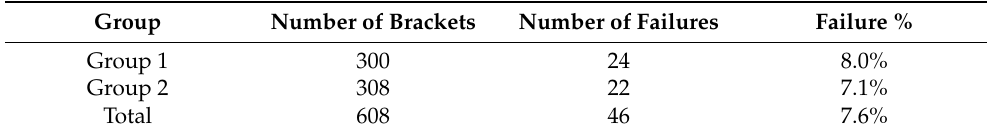
Table 2. Frequencies of debondings in the two